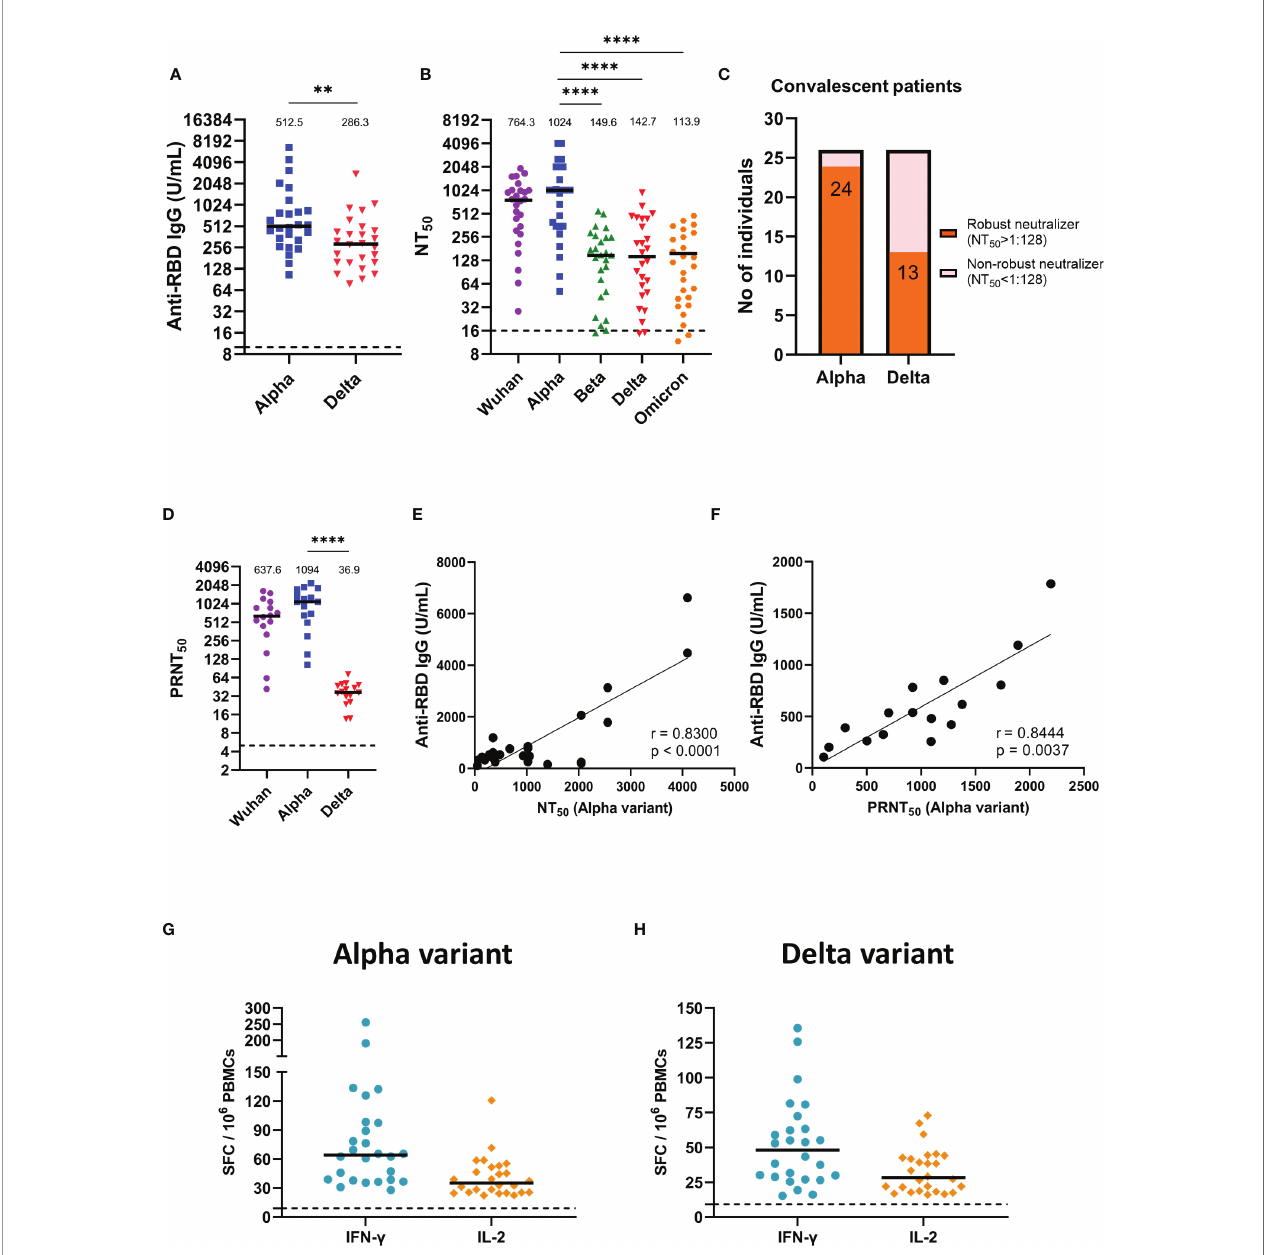
FIGURE 1 | Humoral and cellular immune responses of alpha variant convalescents. (A) Results of ELISA measuring serum reactivity to anti-RBD IgG (n = 26). (B) NT 50 of alpha variant convalescent sera (n = 26) measured with indicated SARS-CoV-2 pseudovirus variants. (C) Fraction of robust neutralizers in the convalescent cohort at 1-month post- infection. Individuals with a pseudovirus NT 50 above 1:128 were classi fi ed as robust neutralizers, while individuals with a pseudovirus NT 50 below 1:128 were classi fi ed as non- robust neutralizers. (D) PRNT 50 of alpha variant convalescent sera (n = 16) detected with indicated real SARS-CoV-2 variants. (E) Correlation between alpha variant anti-RBD IgG titers and NT 50 . (F) Correlation between alpha variant anti-RBD IgG titers and PRNT 50 . (G, H) IFN- g and IL-2 ELISpot of alpha variant convalescents PBMCs stimulated with (G) alpha variant or (H) delta variant peptide pool. SFC, spot-forming cells. The dotted line represents the cut-off value for each assay. Duplicates were performed for each tested sample. Measured statistical signi fi cance was calculated among experiments by one-way ANOVA with Tukey ’ s multiple comparison test. Simple linear regression and Pearson correlation analysis were conducted to determine the correlation coef fi cients. Asterisks indicate statistical signi fi cance, **p < 0.01, ****p <